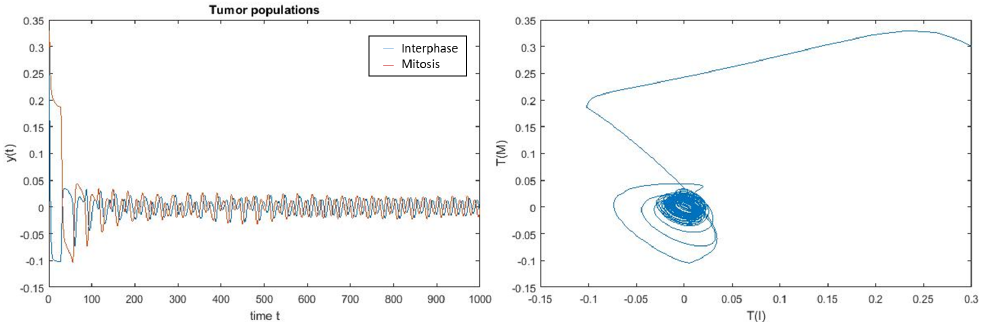
Figure 8. Tumour population with two immune response when τ = 27.6458 at E 0 = ( 0,0,15,0 ) .